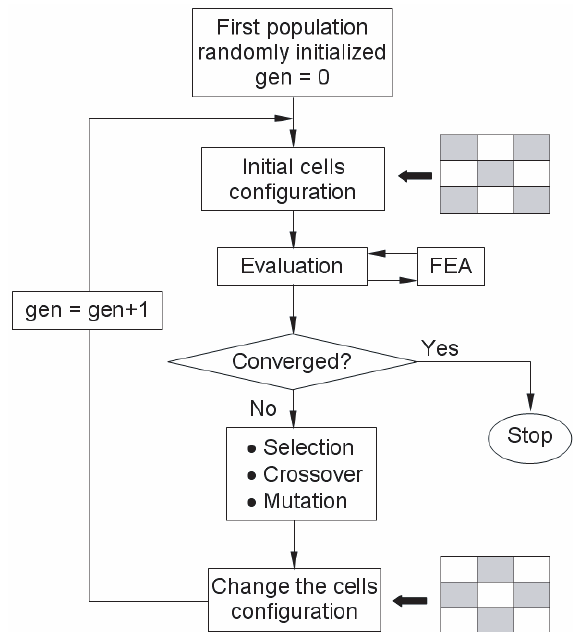
Fig. 6. Flow chart of the proposed approach.